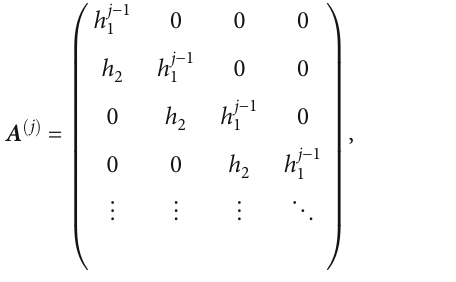
Table 1: Estimates of I